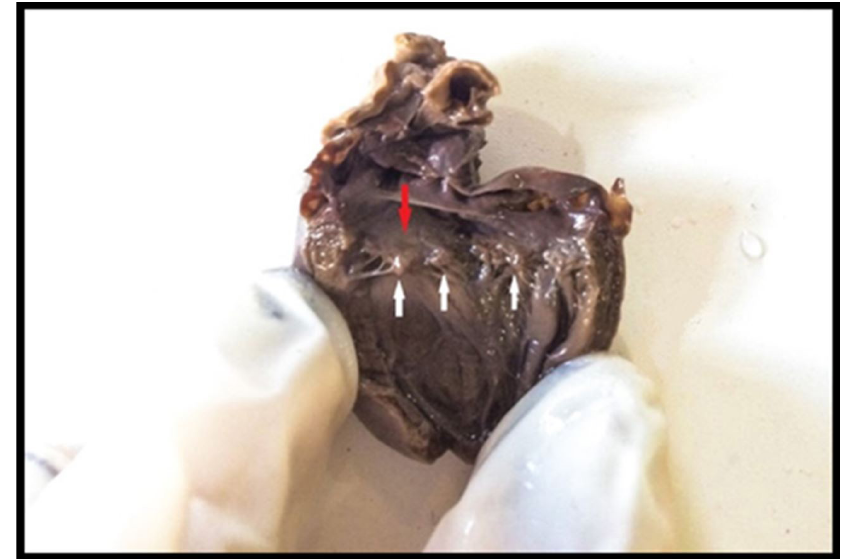
Figure 1. Longitudinal section of a heart, showing the left atrioventricular valve, the presence of nodules (white arrows), and increased opacity and thickening (red